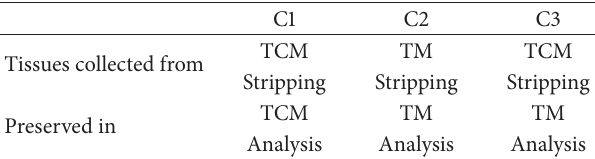
Table 1: Different conditions of preservation media to store preloaded DMEK lenticules. C1 C2 C3 TCM TM TCM Tissues collected from Stripping Stripping Stripping TCM TM TM Preserved in Analysis Analysis